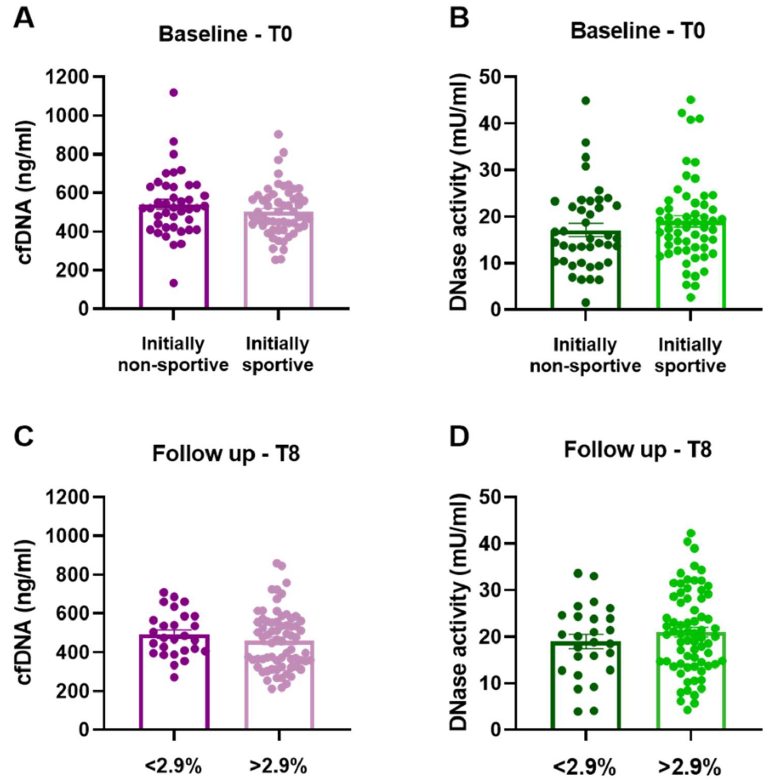
Figure 2. Levels of cfDNA and DNase activity at baseline and after 8 months of training intervention. ( A ) Baseline cfDNA levels, p = 0.212 and ( B ) baseline DNase activity, p = 0.318 of the initially non-sportive (n = 41) and sportive group (n = 57) group. 8-month ( C ) cfDNA levels, p = 0.281 and ( D ) DNase activity, p = 0.311, of groups with <2.9% (n = 27) and >2.9% (n = 71) performance gain. Data are presented as scatter dot plots with mean ± SEM, and were compared by unpaired two-tailed t -tests. Table 2. Backwards multiple linear regression analysis of cfDNA levels at